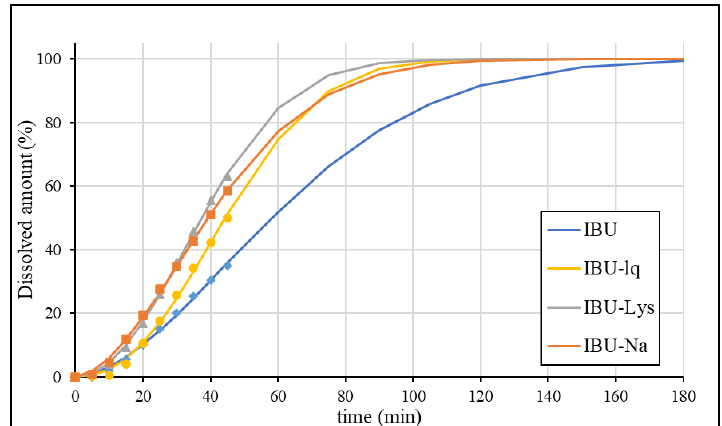
Figure 10. Fitted dissolution data using the Weibull function.